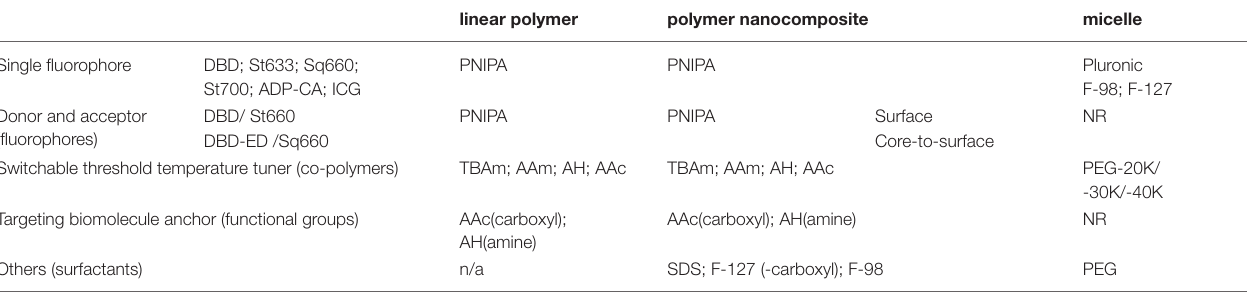
TABLE 2 | Overview of components of USF contrast